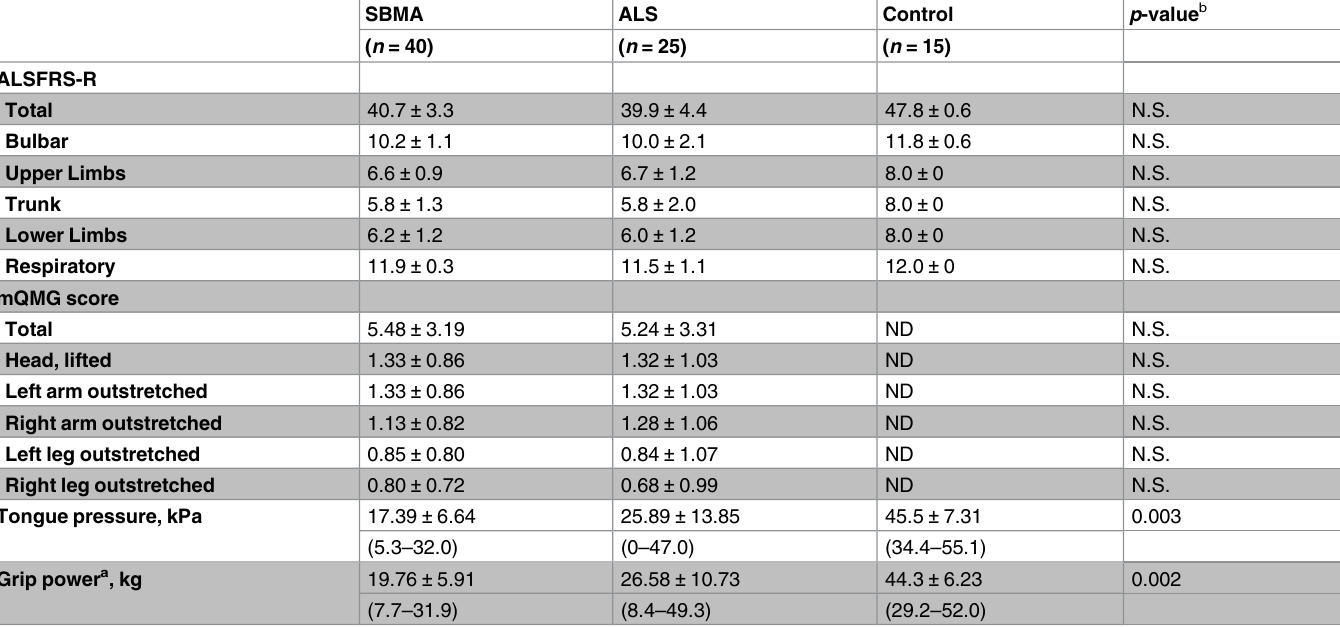
Table 3. Motor function of subjects.